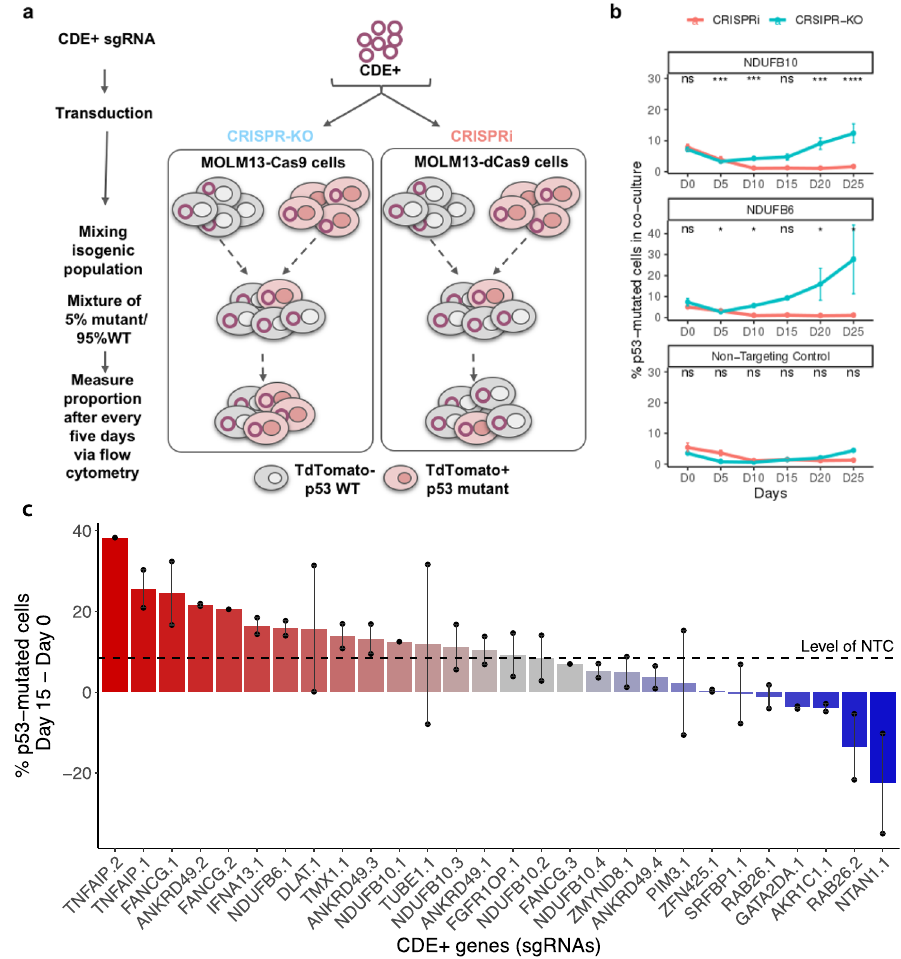
Fig. 3 Selection for p53 mutant cells under CRISPR-Cas9 knockout of CDE + genes in a co-culture of p53 WT/mutant cells. a An illustration showing the experimental design of the competition assay where isogenic p53 WT/mutant MOLM13 cell lines were mixed with a ratio of 95:5 and top p53 CDE + genes were knocked out by CRISPR-Cas9. The population ratio was monitored for 25 days at a 5-day interval starting from the day of sgRNA transduction. b Change in the percentage of p53 mutant cells in the p53-mutant WT cells ( y -axis) co-culture with time ( x -axis, number of days in co-culture), under the CRISPR-KO or CRISPRi of individual selected top p53 CDE + genes or with non-targeting control sgRNA. The p -values are calculated using two-sided Wilcoxon Rank Sum tests. Data are presented as mean values ± SEM across N = 2 independent biological replicates (unique sgRNAs). c The difference of the percentage of p53 -mutant cells between Day 15 and Day 0 in co-culture ( y -axis), under the CRISPR-KO of a larger set of top p53 CDE + genes ( x -axis, by individual sgRNAs, speci fi ed by number suf fi xes after gene symbols). Similar to panel ( a ), data are presented as mean values where the error bars represent standard error across replicates for each sgRNA. Data are presented as mean values± SEM across N = 3 independent biological replicates (unique sgRNAs). The horizontal dashed line represents the value for non-targeting control sgRNA